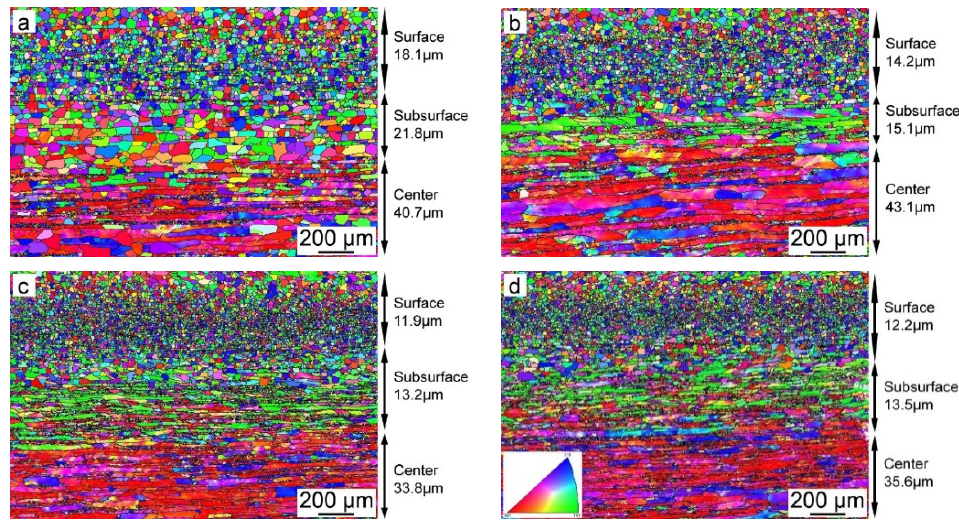
Figure 4. OIM of hot-rolled bands: ( a ) Nb-free, ( b ) Nb-0.005 wt%, ( c ) Nb-0.009 wt% and ( d ) Nb-0.025 wt%.